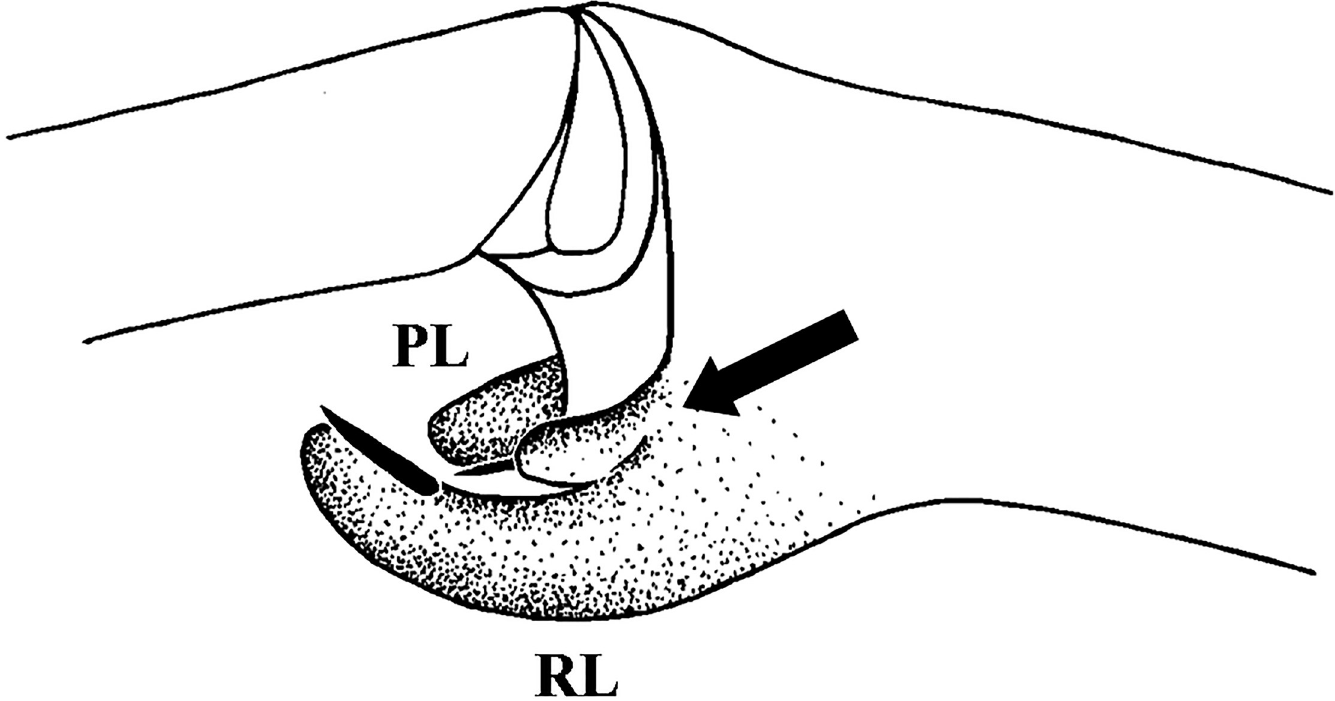
Fig 16. Ephebopus rufescens West & Marshall, 2000, male tibia I with prolateral (PL) and retrolateral (RL) tibial apophysis. The arrow shows a third additional tibial apophysis at the base of the retrolateral apophysis. Leg segments without covering setae.